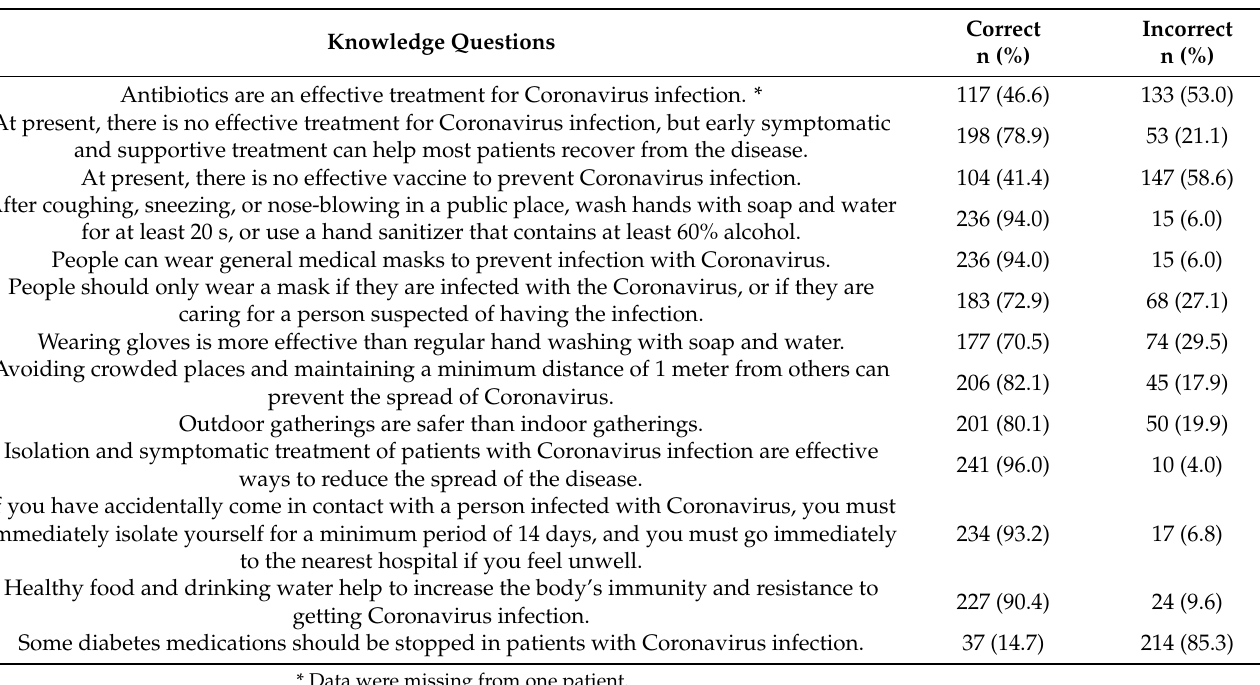
Table 5. Patients’ responses to questions related to knowledge about COVID-19 management, prevention, and control (n =